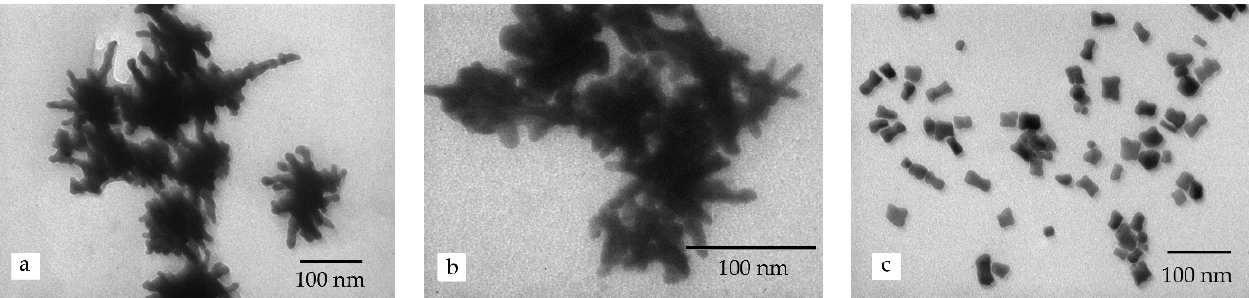
Figure 10. TEM images of GNS prepared in different sonication time—( a ) 6 min, ( b ) 8 min and ( c ) 10 min. Table 10. The influence time sonication to morphology, average core and branches of GNS. Table 9. The influence of time sonication to surface plasmon resonance and intensity absorbance. US Time (min)